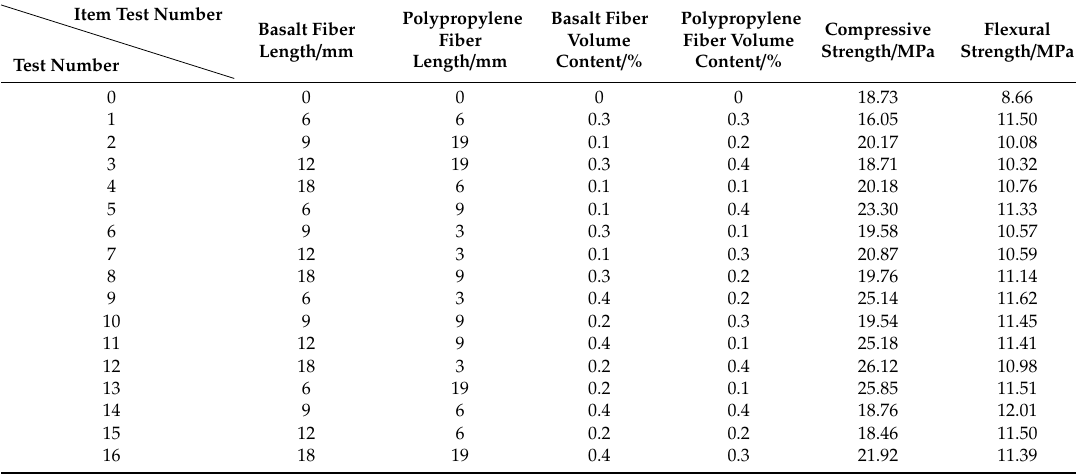
Table 5. Orthogonal Test